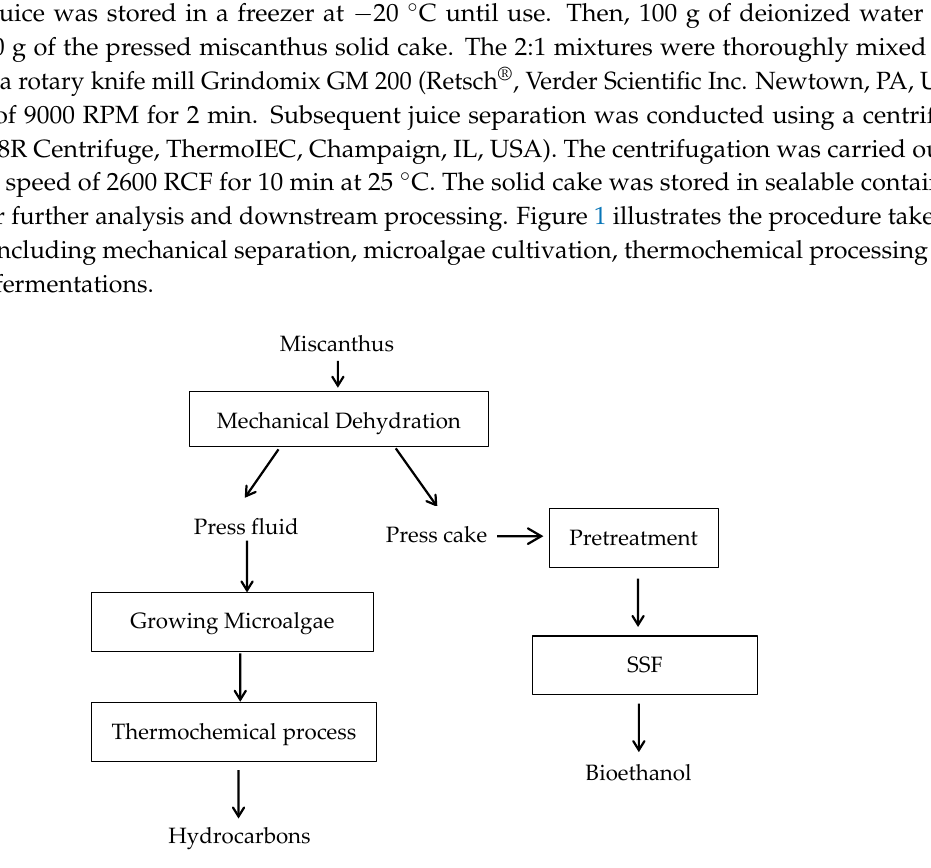
Figure 1. Flow chart of the integrated generation of bioethanol and hydrocarbons from uses of MxG’ solid and liquid fractions. (SSF: Simultaneous saccharification and fermentation).